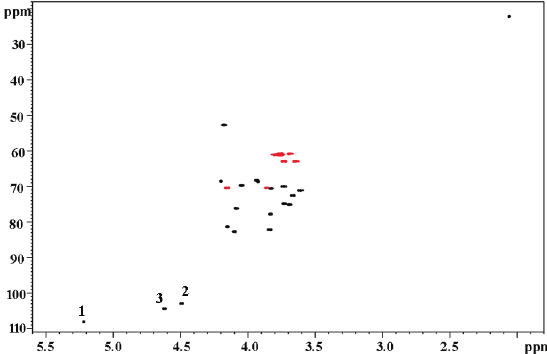
Figure 4 - 1 H- 13 C HSQC spectrum of the trisaccharide alditol from epimatigotes of T. cruzi strain Silvio X10/1 (CH black, CH red). 1. Gal f -β-1-4-GlcNAc-ol; 2. Gal p -β-1-6-GlcNAc- 2 ol; 3. Gal p -β-1-2-Gal p .